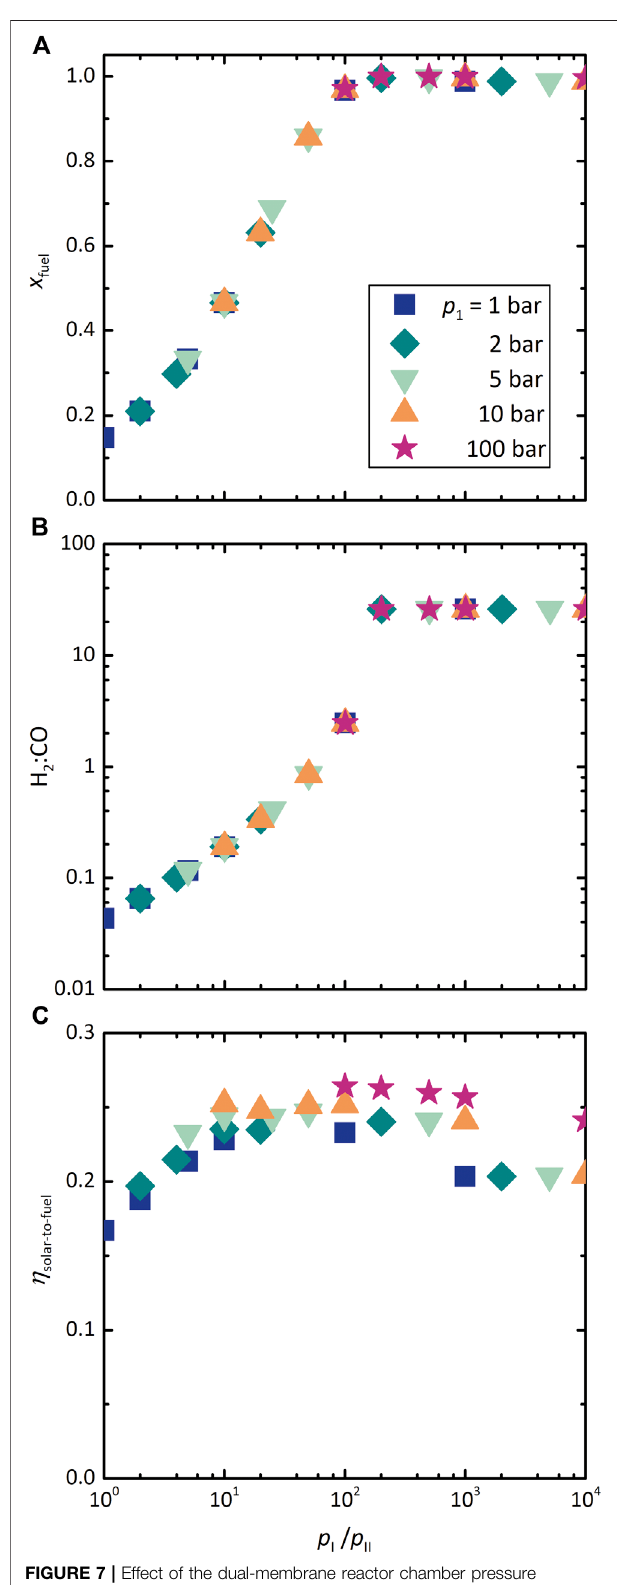
FIGURE 7 | Effect of the dual-membrane reactor chamber pressure ratio, p I : p II , on (A) x fuel , (B) H 2 :CO molar ratio, and (C) η solar-to-fuel at various (cid:2) 10 values of p I . T (cid:2) 1,800 K and p O 2